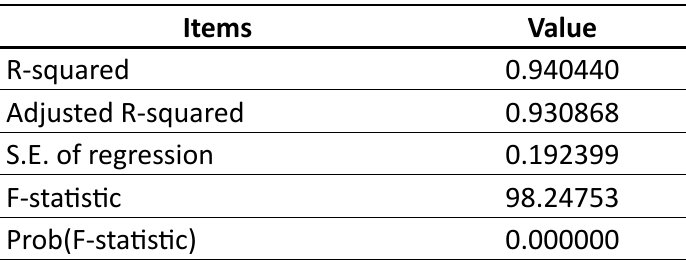
Table 5: Result of R 2 and F- statistic